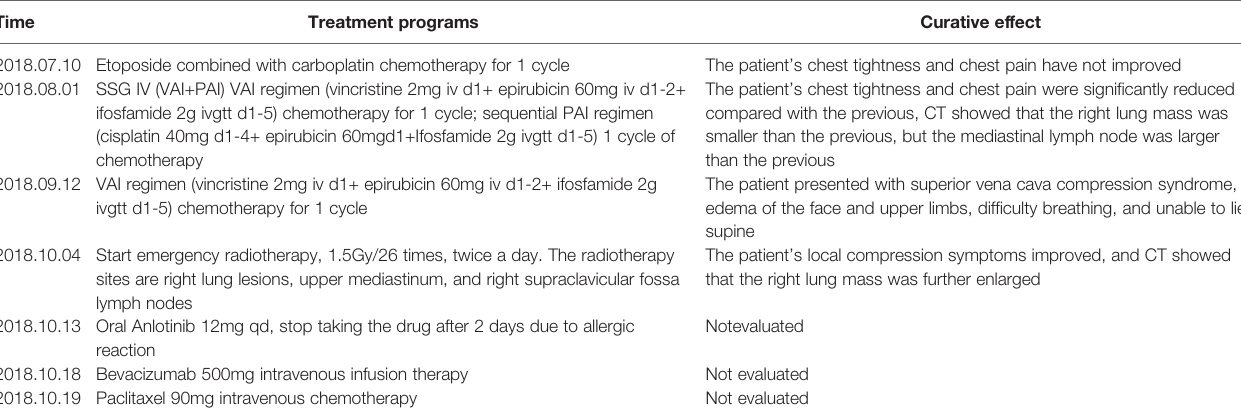
TABLE 1 | The treatment received by the patient and its